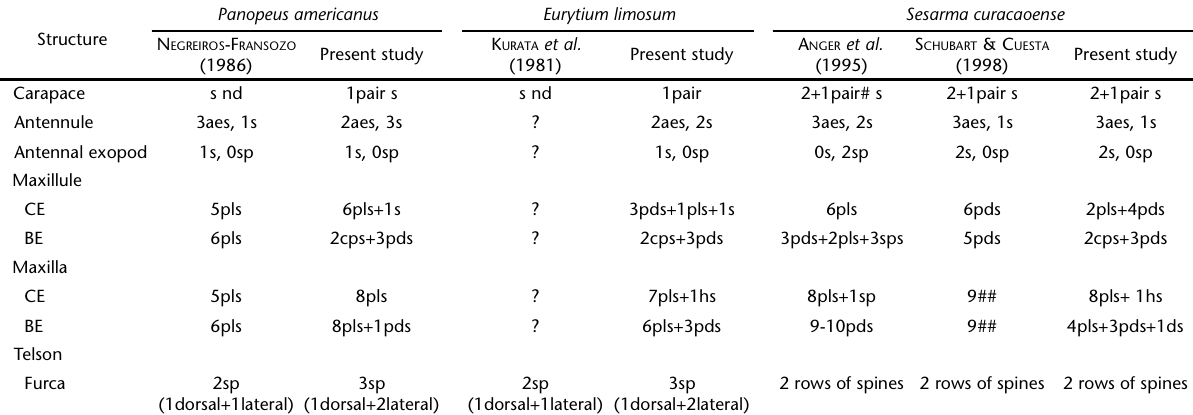
2 rows of spines (CE) coxal endite, (BE) basial endite, (s) simple seta, (pls) plumose seta, (pds) plumodenticulate seta, (cps) cuspidate seta, (aes) aesthetascs, (sp) spine, (sps) sparsely plumose seta, (hs) seta similar to the hamate, (nd) not described, (?) not defined, (#) only illustrated by the author, (##) type of seta not